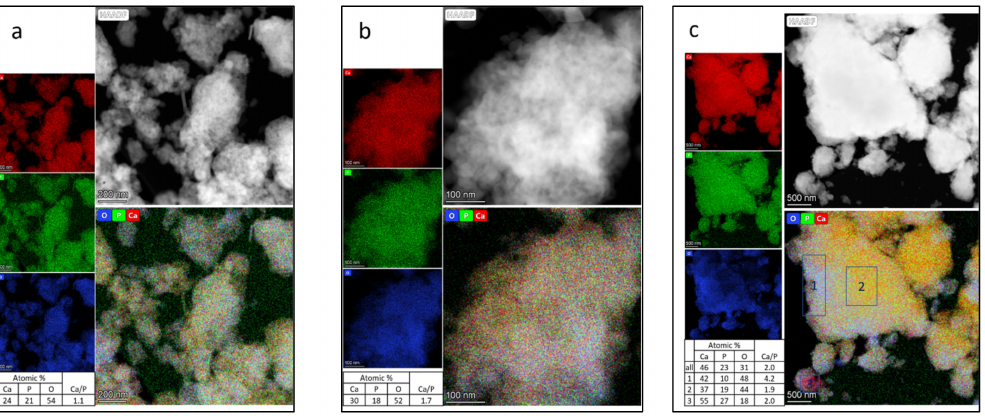
Figure 6. Distribution maps of elements across a particle in samples with Ca/P ratios 1.25 ( a ), 1.42 ( b ), and 2.00 ( c